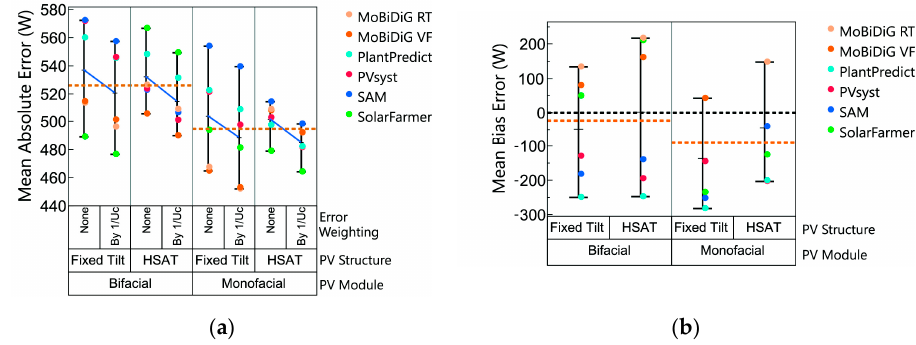
Figure 10. ( a ) Variability plot showing the mean absolute error of DC power for the four PV system types as simulated by six software. The chart displays unweighted error and error weighted by the inverse of the uncertainty of the solar radiation measurements. ( b ) Variability plot showing the mean bias error of DC power. Only the unweighted error is shown in these plots. The dashed orange lines show the mean error of the bifacial and monofacial arrays.